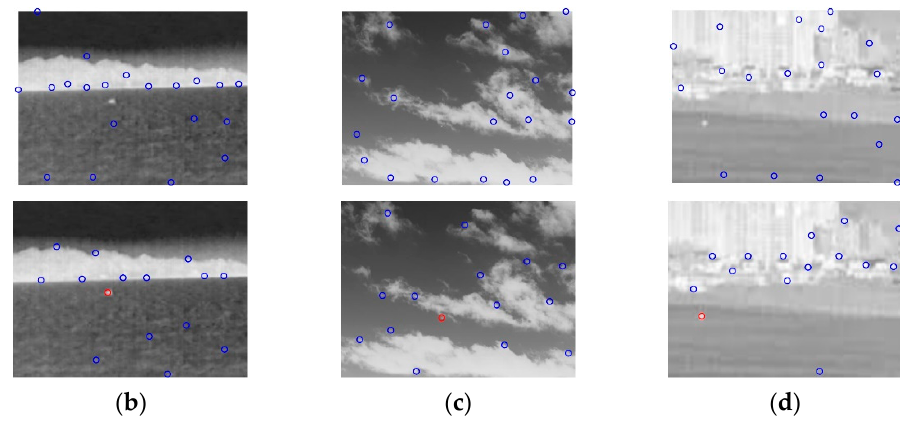
Figure 10. The detection results of the proposed method and DPS-GVR. ( a – d ) Four images selected from Seq.1 with high-brightness background clutter around the target. The first row shows the result of DPS-GVR and the second row shows the result of the proposed method.